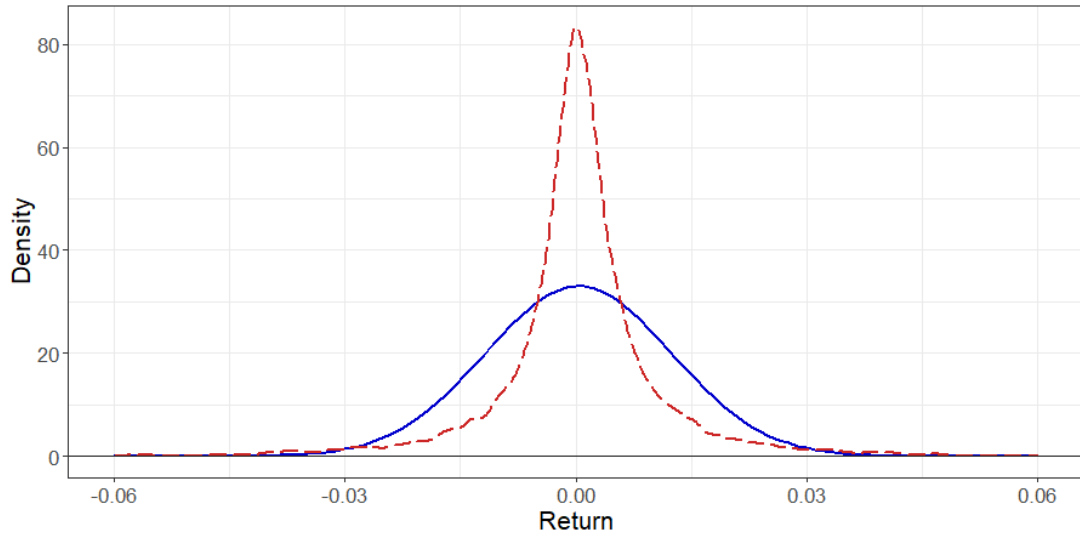
Fig. 7. Kernel density of Bitcoin two-hour returns (dotted red) compared with the probability density function of a normal distribution with the same mean and variance (solid blue).